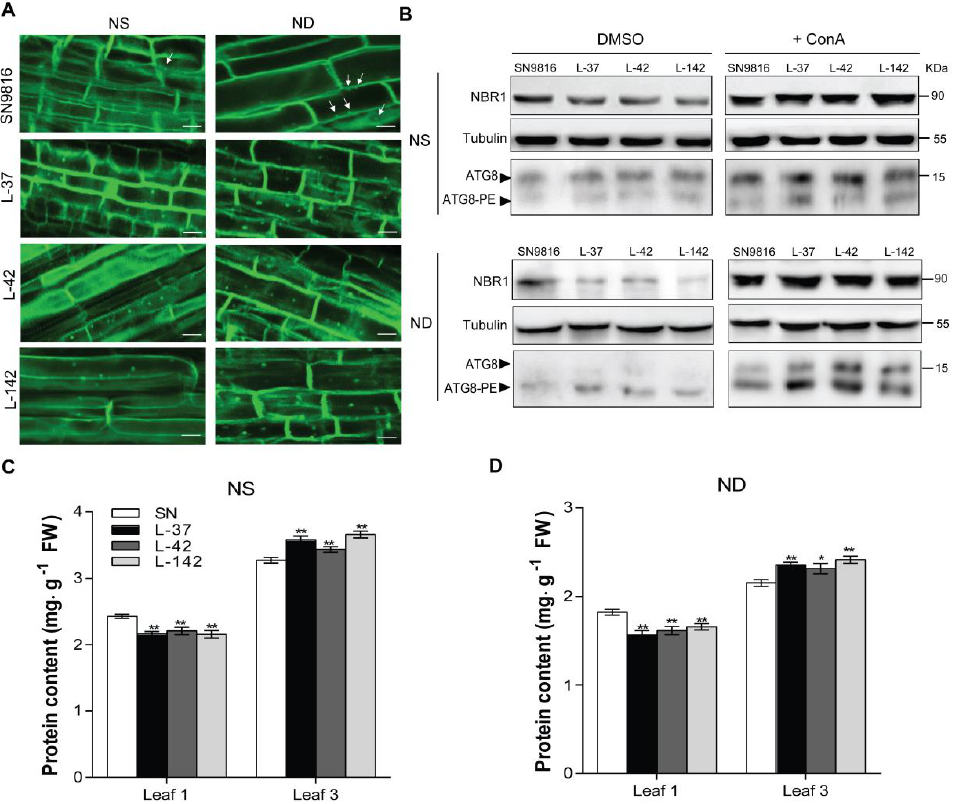
Figure 4. The overexpression of OsATG8c enhanced the autophagy levels and affected leaf protein profiles in rice. The 21-day-old seedlings of SN9816 and overexpressors were transferred to NS (3.5 mM N) or ND (0 mM N) liquid medium for 24 h. ( A ) Confocal analysis of autophagosomes in roots by monodansylcadaverine (MDC) staining. MDC-labeled structures are shown in green. The white arrowheads indicate the MDC-stained autophagosomes. Scale bars: 10 μm. ( B ) Fourteen-day-old seedlings were transferred to NS (3.5 mM N) and ND (0 mM N) liquid media with 0.5 µM concanamycin A (ConA) or solvent control DMSO for 24 h. Immunoblot analysis was used to determine the accumulation of NBR1 with anti-NBR1 in Arabidopsis; near-equal protein loads were confirmed with an α -tubulin antibody. The membrane fraction was used to detect lipidated (ATG8-PE) and free ATG8 levels with anti-Arabidopsis ATG8a in leaves. ( C ) The protein content of old leaves (Leaf 1) and ( D ) young leaves (Leaf 3) in SN9816 and transgenic rice under NS or ND conditions. The protein content in equal weight leaf samples was determined by bicinchoninic acid (BCA) protein assay, which was represented as mg protein / g fresh weight. Values are the means ± SD ( n = 3), * p < 0.05, ** p < 0.01 ( t